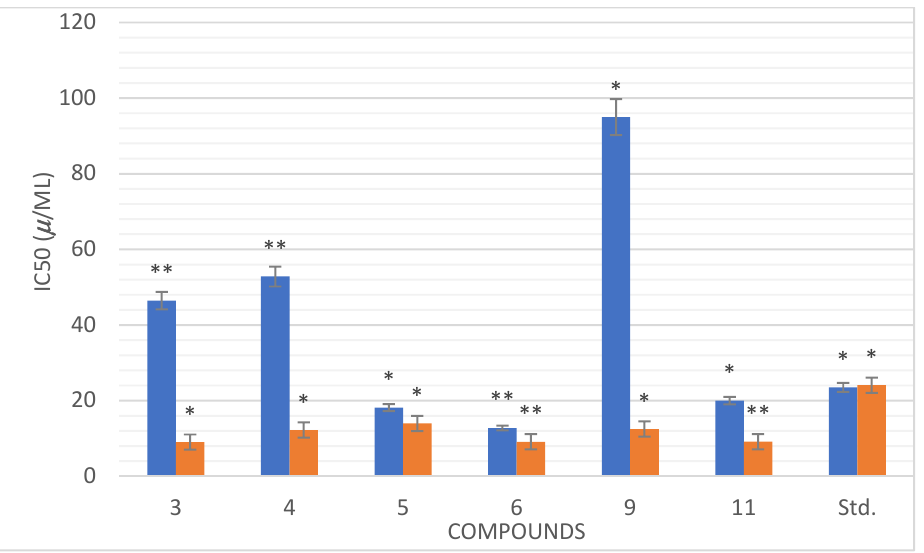
Figure 5. IC 50 in ( µ g/mL) for the tested compounds ( 3 – 6 , 9 , and 11 ) compared to ascorbic and acarbose, respectively, as standard drugs for DPPH radical (orange) and α -amylase enzyme (blue), respectively. Data analyzed by one way ANOVA followed by LSD test and expressed as mean ± SEM from five observations; * represents change as compared to control; ** indicates p < 0.01 and * shows p < 0.05.